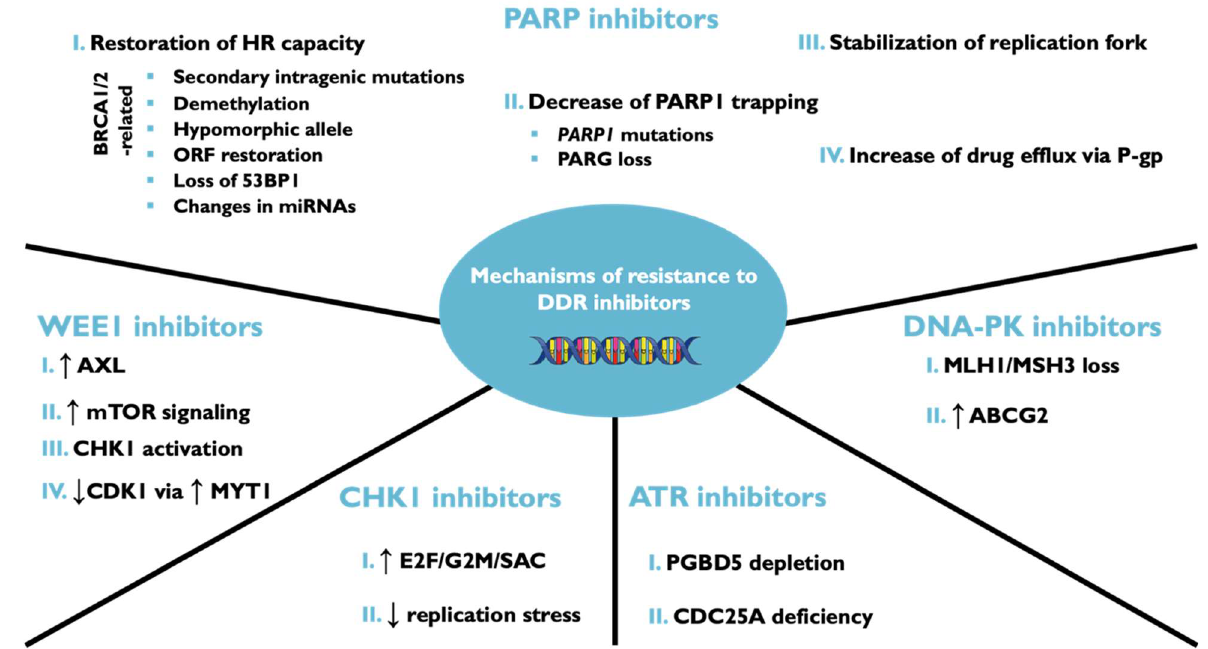
Figure 1. Mechanisms of resistance to DDR inhibitors. Cancer cells develop resistance to DDR through several mechanisms. The molecular mechanisms of resistance to PARPi include HR capacity restoration, decreased trapping of PARP1, stabilization of replication forks, and P-gp-mediated drug efflux. The resistance to WEE1 inhibitor is induced by AXL overexpression, mTOR signaling, CHK1 activation, and through the overexpression of MYT1 that decrease CDK1 activity. The resistance to CHK1 inhibitor is associated with increased E2F/G2M/SAC expression and reduced replication stress. The resistance to ATR inhibitor is induced by the loss of PGBD5 and CDC25A deficiency. Finally, the DNA-PK inhibitor resistance is caused by the loss of MLH1/MSH3 and the overexpression of